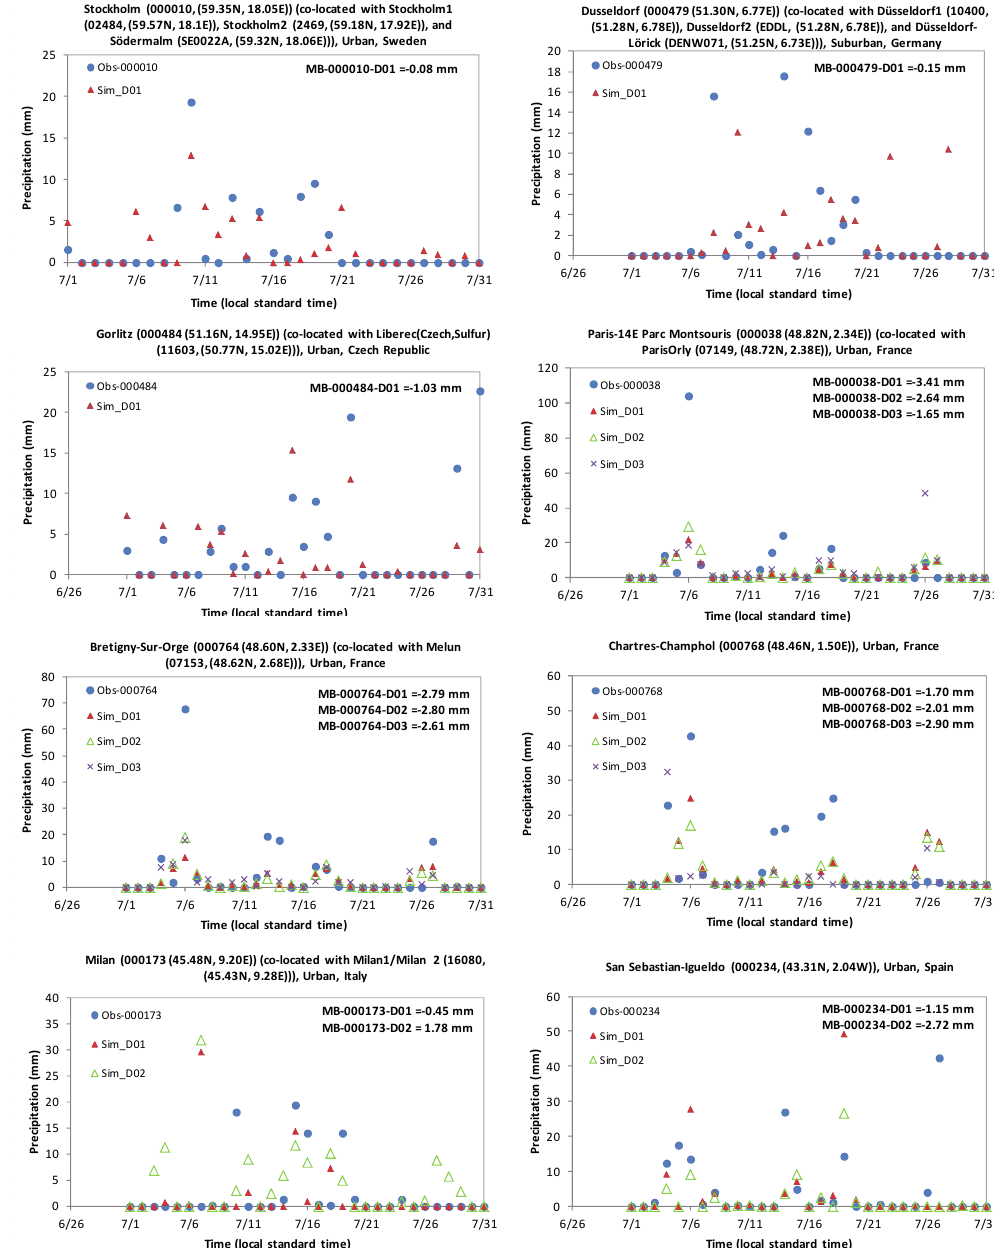
Figure 17. Simulated and observed daily precipitation in July 2001 at selected site. Fig. 17. Simulated and observed daily precipitation in July 2001 at selected